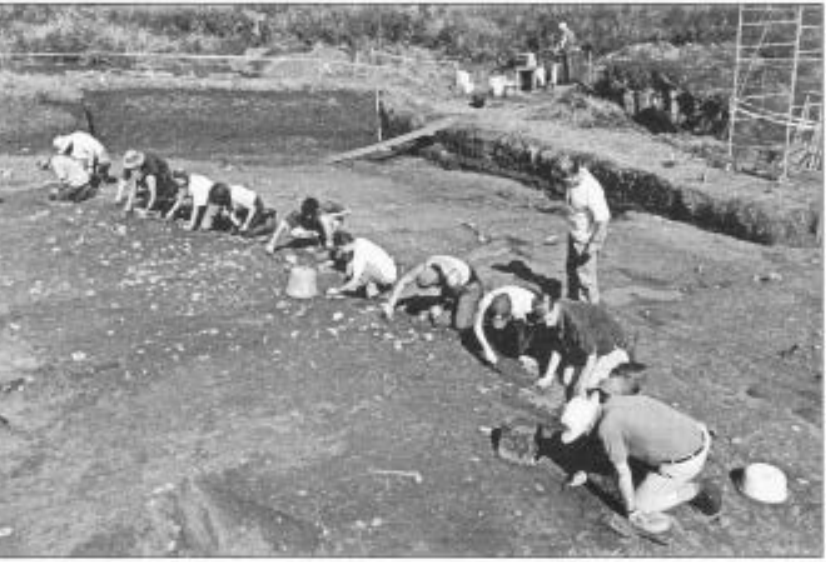
Figure 4 Open-area excavation in progress on the lower slope of the Boneyard site, 1999. The line of trowellers removes little material evenly over a large area, allowing sub­ tle soil contrasts to be observed when they first appear and ephemeral evidence that would otherwise be missed to be